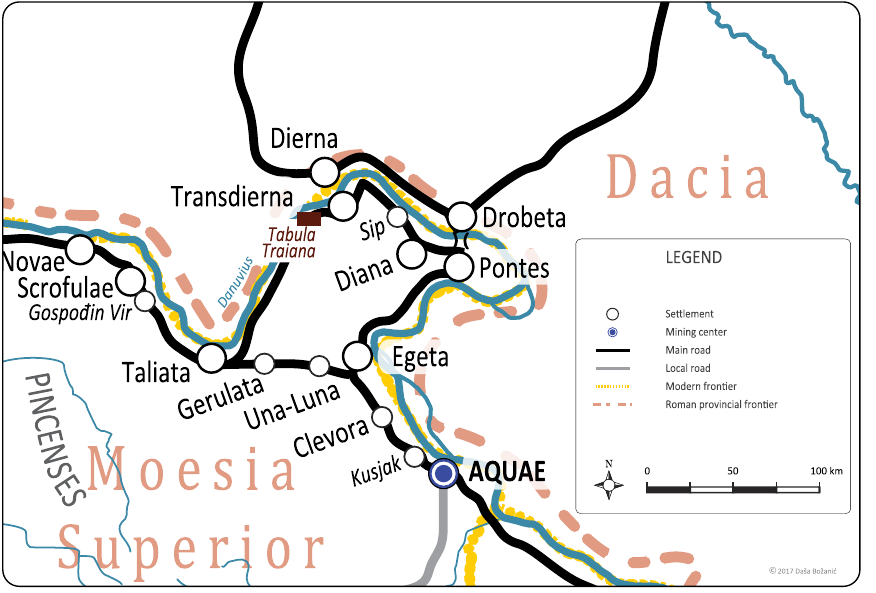
Figure 1. Map of the Danube Frontier Road in Upper Moesia (map by Vladimir